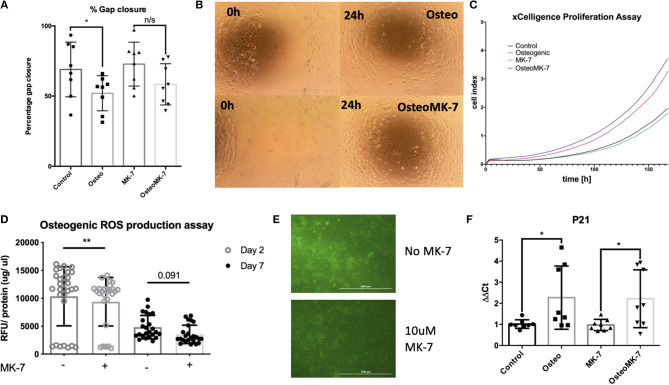
Activity of MK-7 on Migration, ROS and cell cycle regulator P21. Scratch wound assay reveals that MK-7 has the greatest gap closure followed by control, then OsteoMK7 and Osteo last (A). While the difference between osteogenic medium and control alone is statistically significant (p = 0.0499), there is less of a difference in gap closure between OsteoMK-7 and MK-7 (B). xCELLigence proliferation assay reveals that OsteoMK-7 has the greatest increases in proliferation over 1 week compared to the other conditions (C). OsteoMK-7 had significantly higher proliferation (p < 0.0196) compared to Osteo alone. Further MK-7 supplementation significantly reduces the production of ROS species under osteogenic conditions compared to the osteogenic control (D,E) (p = 0.0047). Wherein by day 7 of treatment the differences are no statistically significant but remain (D) also shown by visual representation of the DCFDA staining between the two different conditions (E). Further at day 2 we note by RT-qPCR analysis, a significant upregulation of cell cycle regulator P21 under both osteogenic conditions compared to controls (F) (p = 0.0379, p = 0.0499). *p < 0.05, **p < 0.01.